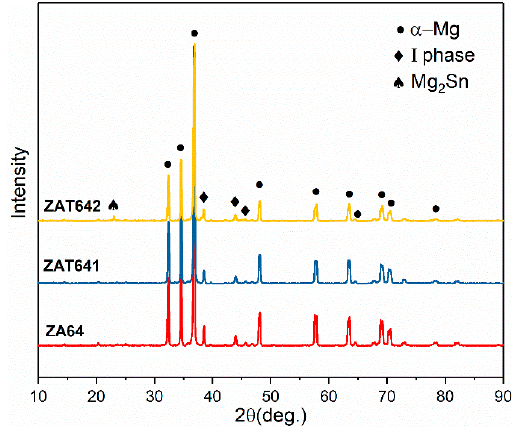
Figure 5. X-ray diffraction (XRD) results of the as-cast Mg-6Zn-4Al- x Sn alloys.